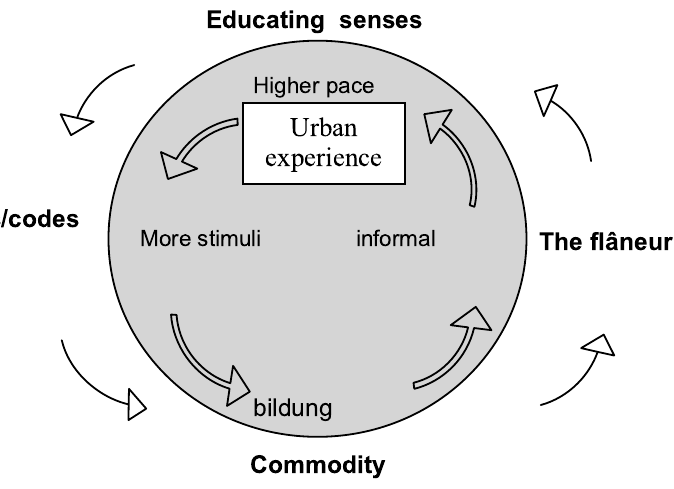
Figure 1. The core and protective assertions in the proposed research program on urban